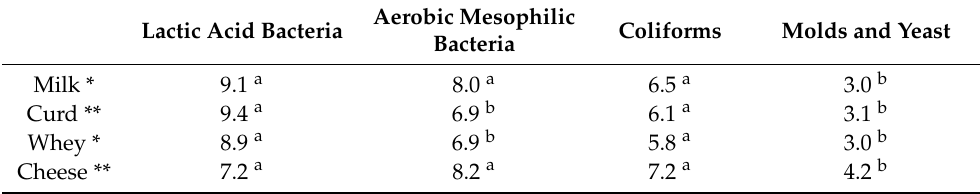
Table 3. Indicator groups in milk, curd and whey not inoculated with pathogens. Lactic Acid Bacteria Aerobic Mesophilic Bacteria Coliforms Molds and Yeast